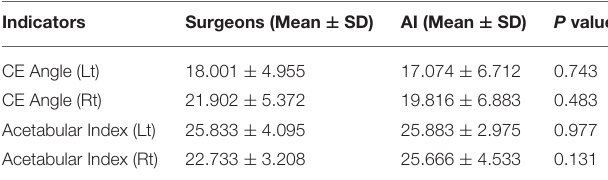
TABLE 3 | Measurement value and variance of four indicators in the AI system and surgeon [center edge (CE) angle (Lt), CE angle (Rt), acetabular index (Lt), acetabular index (Rt)].